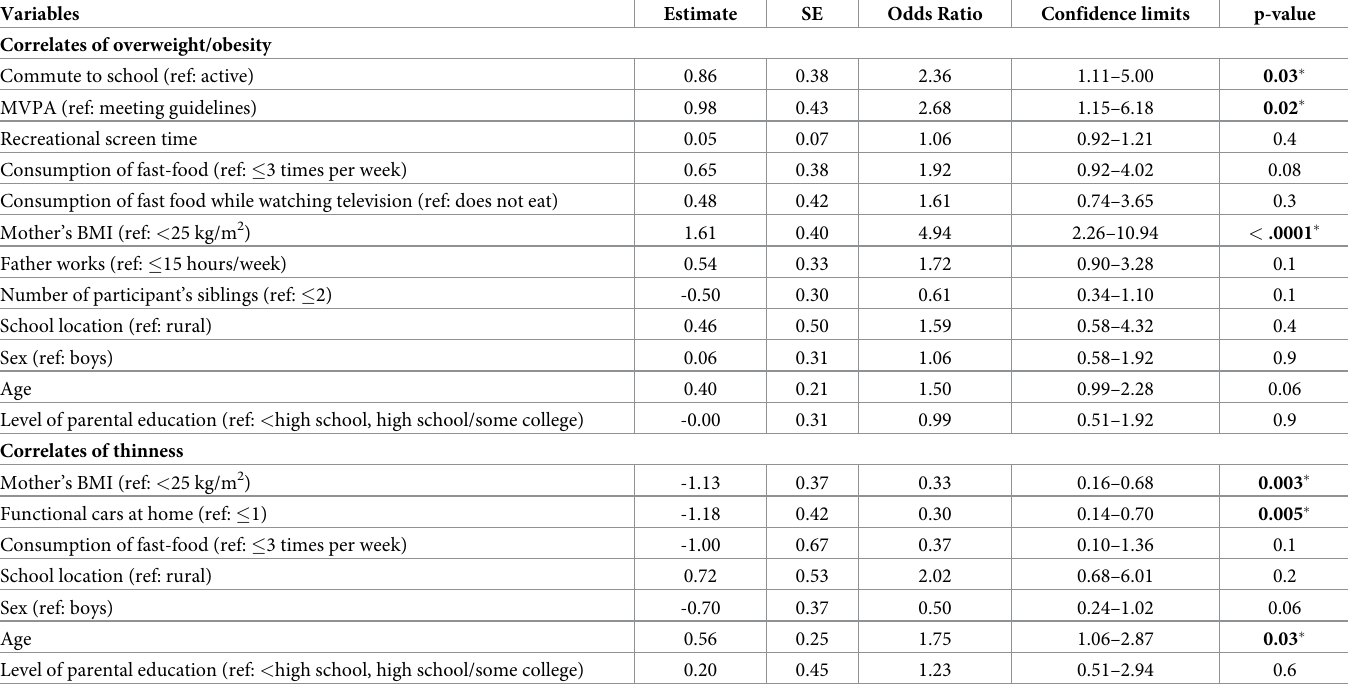
Table 5. Final multivariable